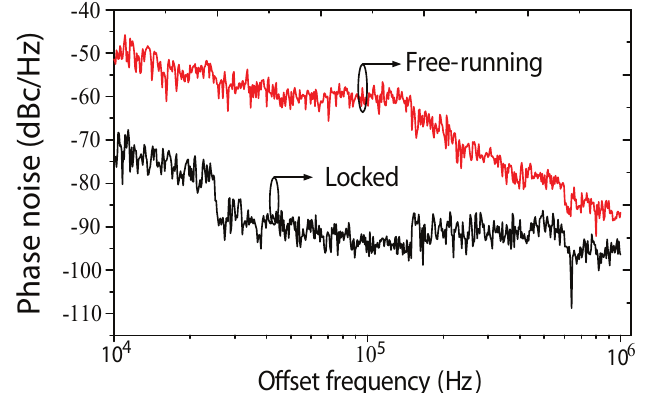
Figure 7. Phase noise of the beat signal in free-running and injection-locked measurement at the modulation frequency of 10